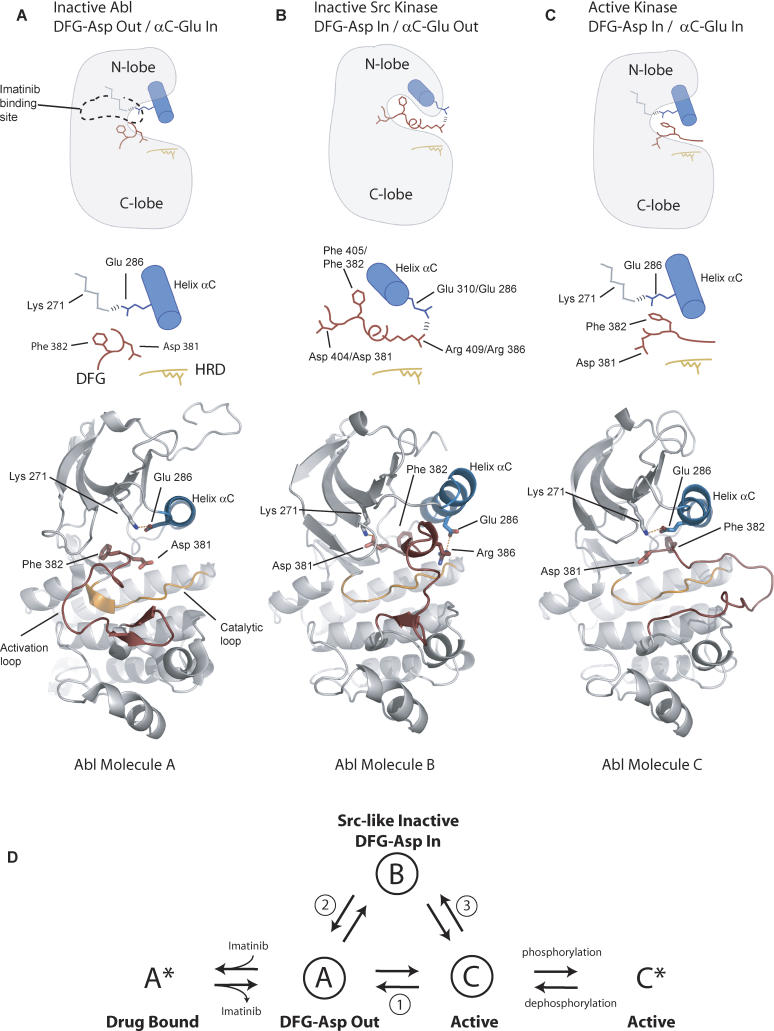
Distinct States of the c-Abl and c-Src Kinase DomainsThree key kinase domain conformations considered at length in the text are shown in (A–C). At the top, a schematic representation of each state and an enlarged schematic are shown, detailing the conformations of the DFG motif (red) and helix αC (blue). Below the schematics the crystal structure of each conformation is shown. The activation loop is colored red, helix αC blue, and the catalytic loop orange.(A) The conformation of inactive c-Abl, bound to imatinib (molecule A).(B) The conformation of the inactive Src family kinases. This conformation is now seen in Abl as well (molecule B, structure 1). Both the c-Src and Abl numbering are indicated.(C) Active Abl (molecule C, structure 2).(D) In cells the active conformation of Abl undergoes rapid autophosphorylation that is expected to trap the protein in the active conformation (indicated as C*). Similarly, imatinib only binds to Abl when the kinase domain adopts conformation A and forms a stable complex with the protein (A*). The interconversion between the different states of Abl is shown in the context of this competition.